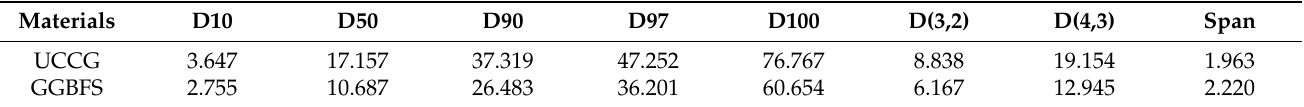
Figure 16. Particle size distribution of UCCG and GGBFS powder. Table 2. Particle size analysis results/ μ m.